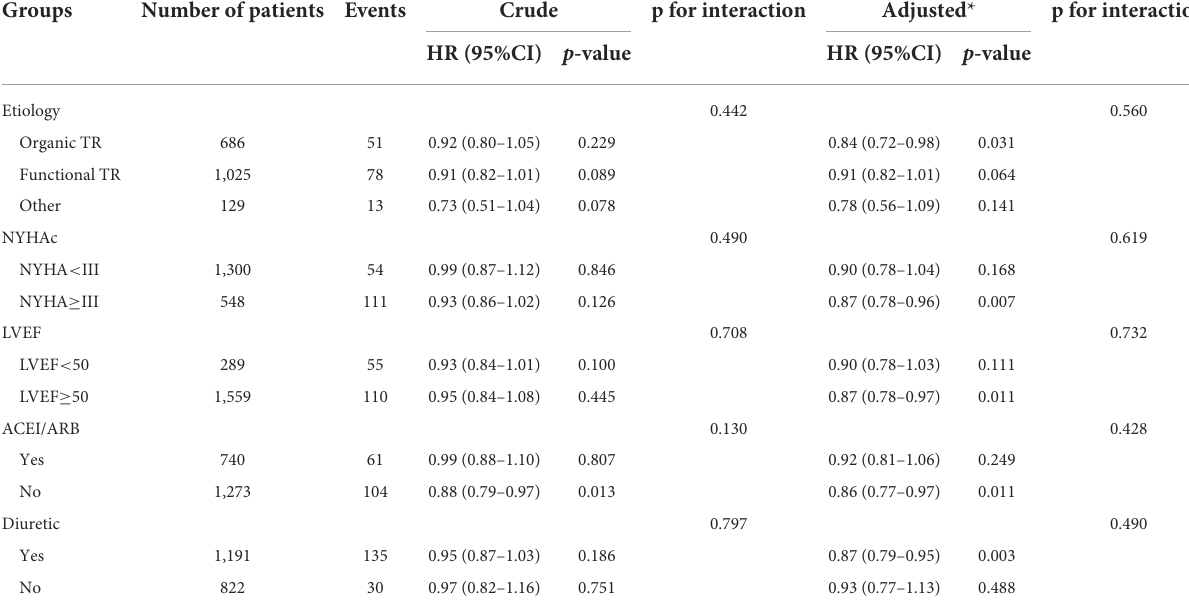
TABLE 4 Subgroup analyses of SBP in clinically meaningful subsets.